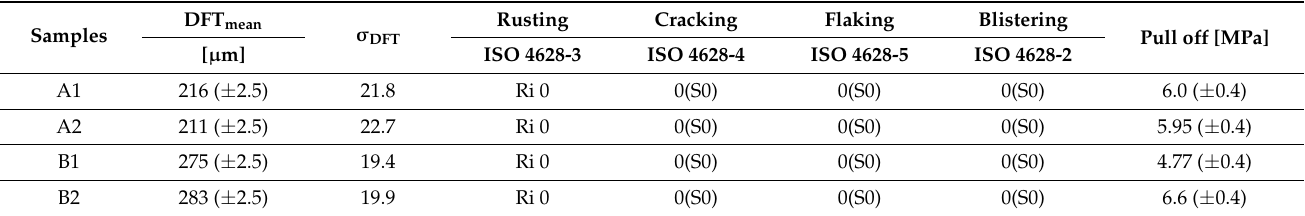
Table 5. Corrosion properties after 30 days (720 h) of testing in the salt spray chamber.